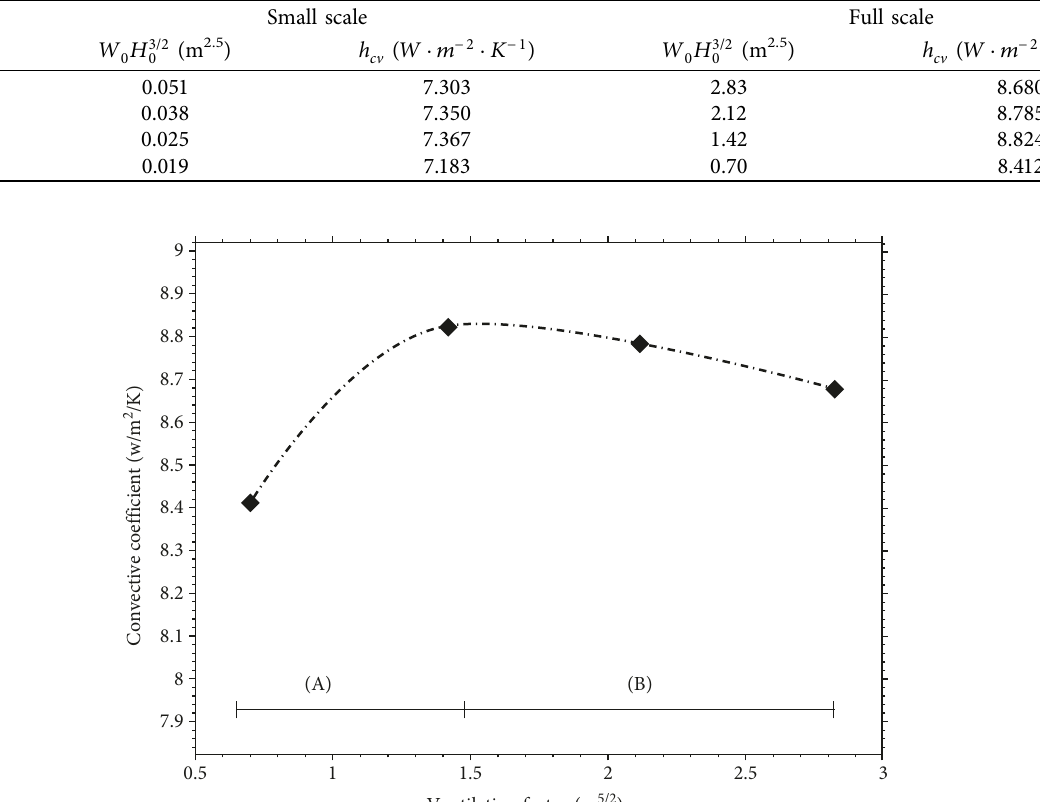
Table 7: Extrapolation of the convective heat transfer coefficient into full-scale fire situation.